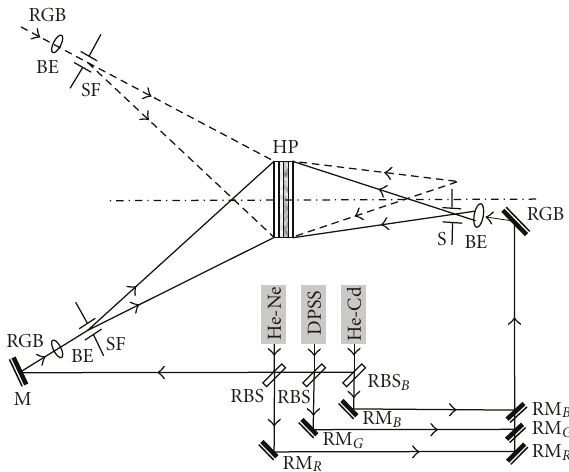
Figure 6: Optical arrangement for recording of reflective holo- graphic